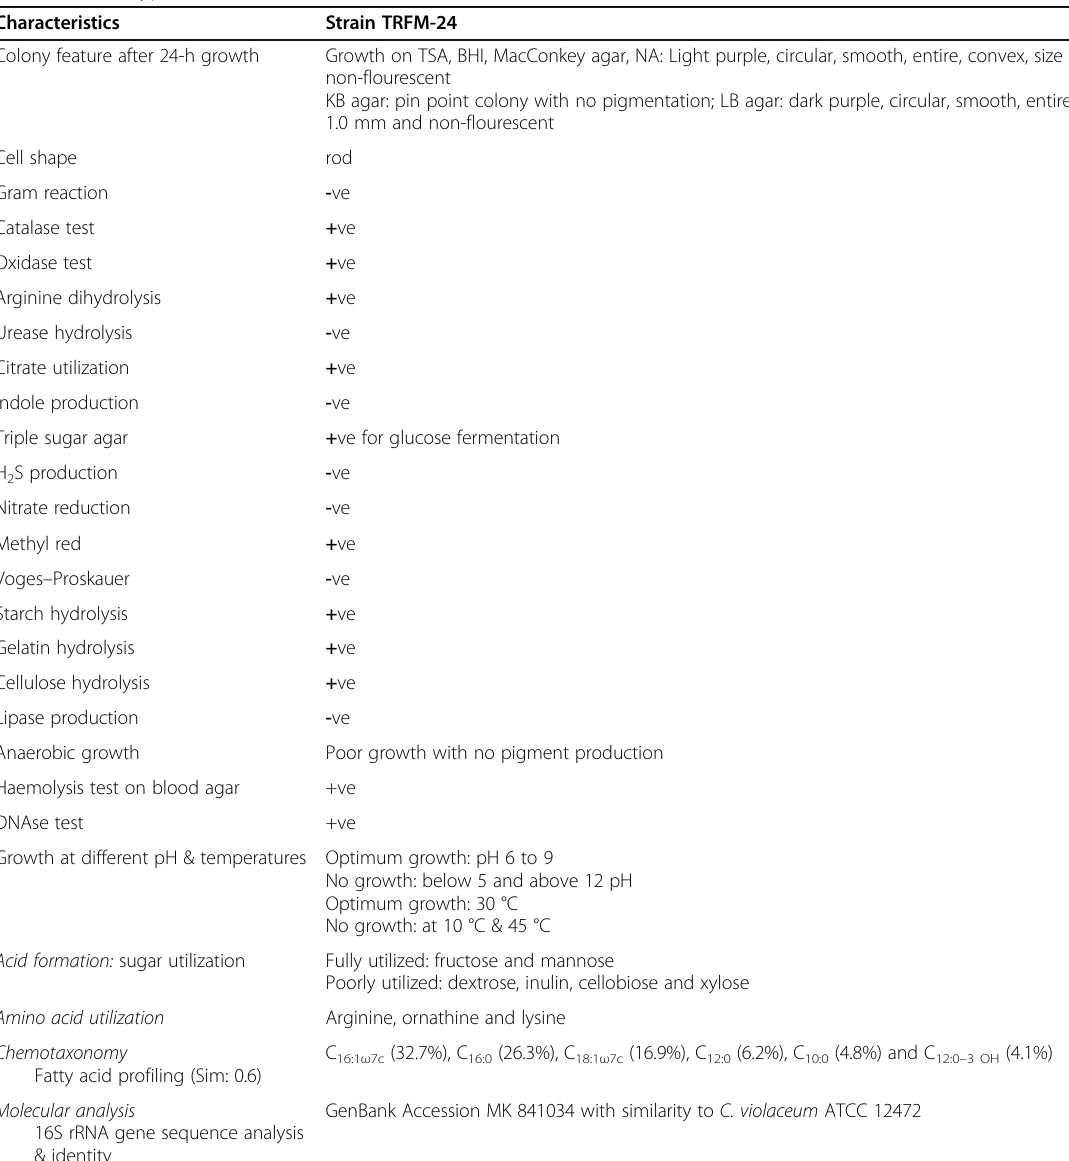
Table 1 Phenotypic and molecular characteristics of Chromobacterium vialoceum strain TRFM-24